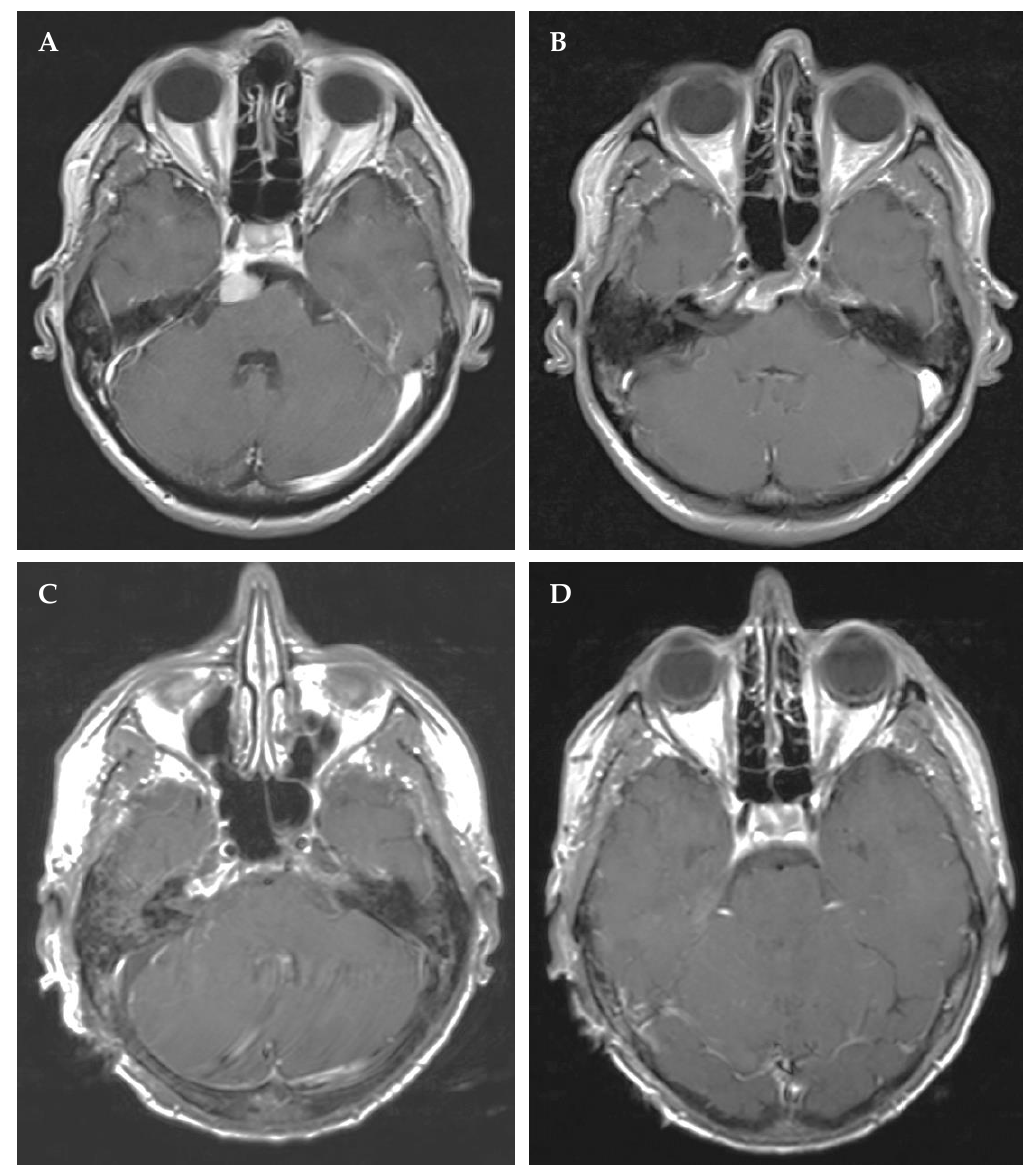
Figure 1. Right petroclival meningioma in a 58-year-old male with tinnitus. The small tumor had been detected 3 years prior to surgery, at an external facility. Preoperative contrast-enhanced T1 magnetic resonance imaging (MRI) in axial ( A , B ) reconstructions without affection of the brain stem or invasion into the cavernous sinus. Postoperative imaging after complete Simpson I resection via a retrosigmoid approach ( C , D ) without new postoperative deficits.